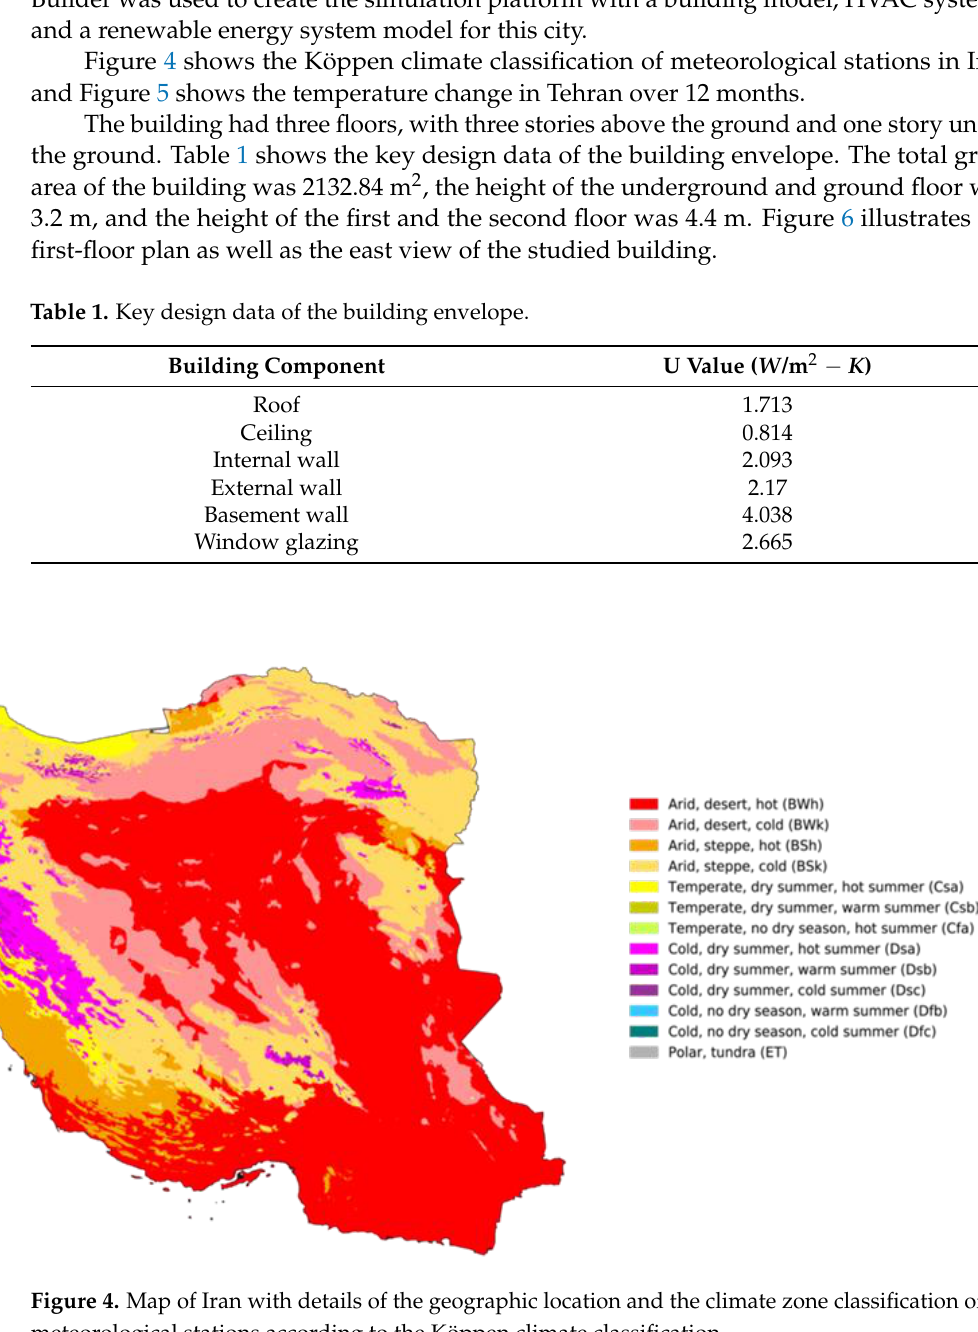
e T Figure 5. Temperature change in Tehran. The building had three floors, with three stories above the ground and one story un- der the ground. Table 1 shows the key design data of the building envelope. The total gross area of the building was 2132.84 m 2 , the height of the underground and ground floor was 3.2 m, and the height of the first and the second floor was 4.4 m. Figure 6 illustrates the first-floor plan as well as the east view of the studied building.